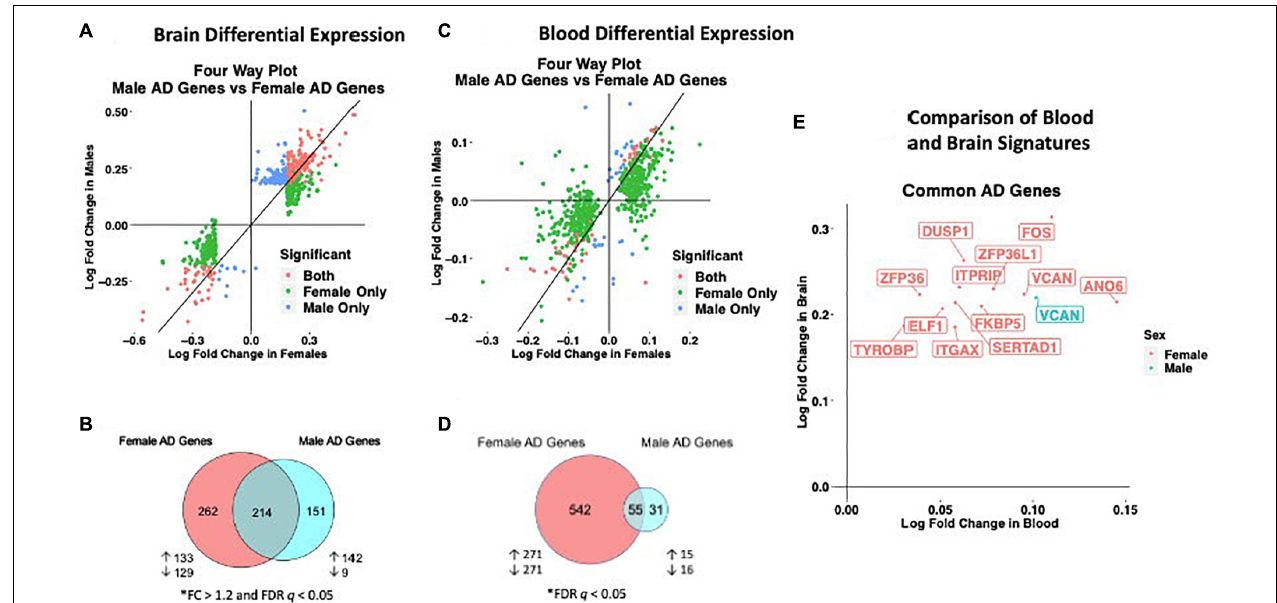
FIGURE 2 | Cross-tissue sex specific differential gene expression. (A) Four-way plot with fold change in males vs fold change in females depicting differentially expressed genes in the brain. Differential expression was defined using a fold change > 1.2 and FDR P < 0.05. Covariates of age and sex were included in statistical analyses. (B) In the brain, a total of 631 genes were uniquely dysregulated in females with AD while 166 genes were uniquely dysregulated in males with AD. Common to both males and females in the brain were 343 genes. (C) Four-way plot with fold change in males vs fold change in females depicting differentially expressed genes in the blood. Differential expression was defined using a fold change > 1.2. Covariates of age, sex, and education were included in statistical analyses. (D) A total of 542 genes were uniquely dysregulated in females with AD while 31 genes were uniquely dysregulated in males with AD in blood. Common to both males and females in the brain were 55 genes. (E) Fold change plot depicting genes that are dysregulated in both blood and brain tissues. Genes are colored by sex indicating if the gene is dysregulated in male samples (1 gene; red) or female samples (31 genes;